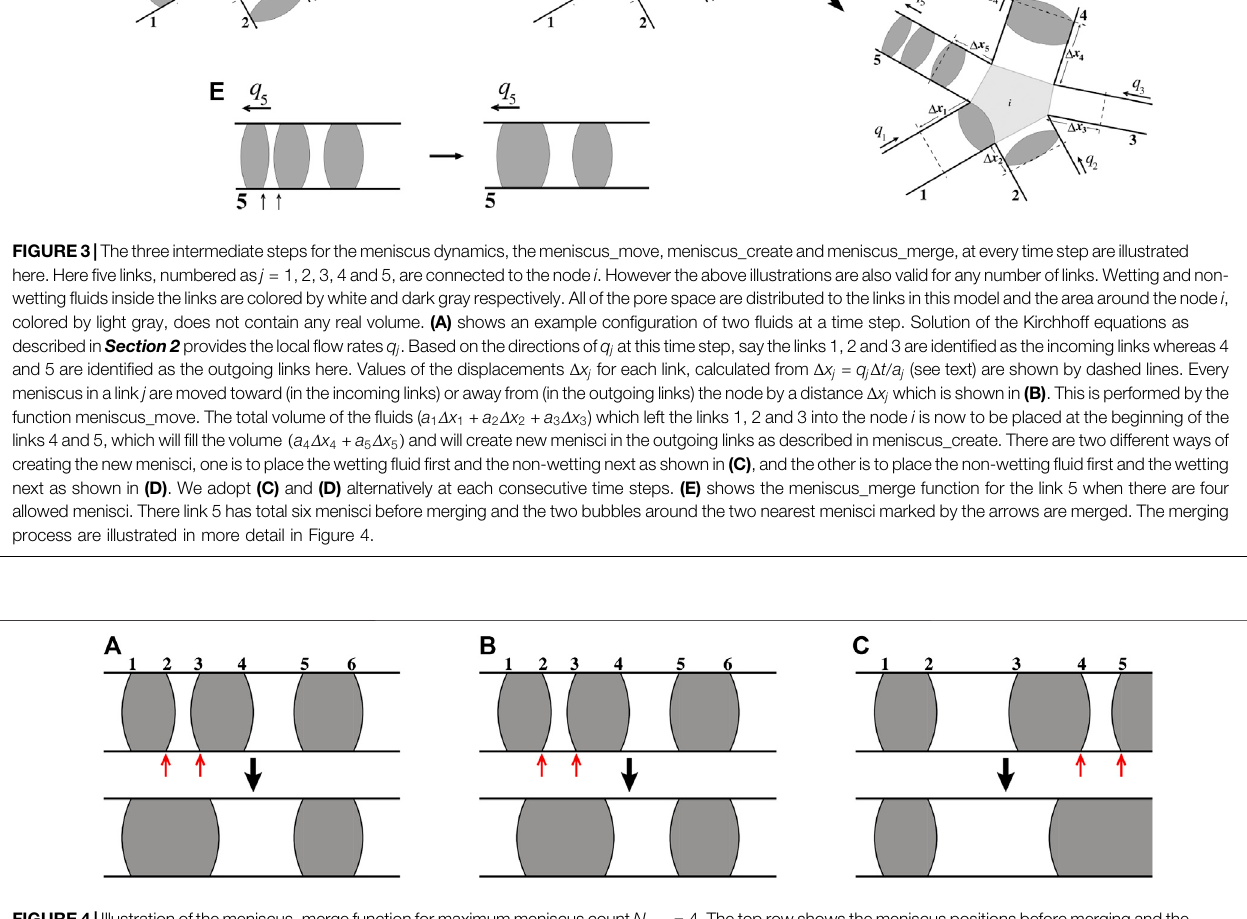
FIGURE4| Illustrationofthemeniscus_mergefunctionformaximummeniscuscount N max (cid:1) 4.Thetoprowshowsthemeniscuspositionsbeforemergingandthe bottom row shows after merging. White and gray represent the two fl uids inside the links. The nearest two menisci are indicated by red arrows. In (A) we show the simplest possible try, namely the merge_back scheme. The link had six menisci before merging among which the menisci 2 and 3 are the nearest. We merge them by movingonly onebubble towardthe other,sothemeniscus1doesnotchange itsposition,onlythemeniscus4ismoved toward 1byadistance thatisequaltothe distance between 2 and 3. In (B) we show the next possible try, namely the merge_cm. Here instead of moving the meniscus 4 toward 1, we move both 1 and 4 toward each other bysuch distances so thatthe center ofmass ofthetwo bubbles do not change after merging. Thethird and fi nal meniscus merging schemeismerge_cmnn, which issameas (B) with an additional criteriaas illustrated in (C) . In the situation when one of the twonearest bubbles is connected toa node, such asthe non-wetting bubbleconnectedtothemeniscus5in (C) ,itwillgetdisconnectedfrom thenode accordingtothemergingscheme (B)